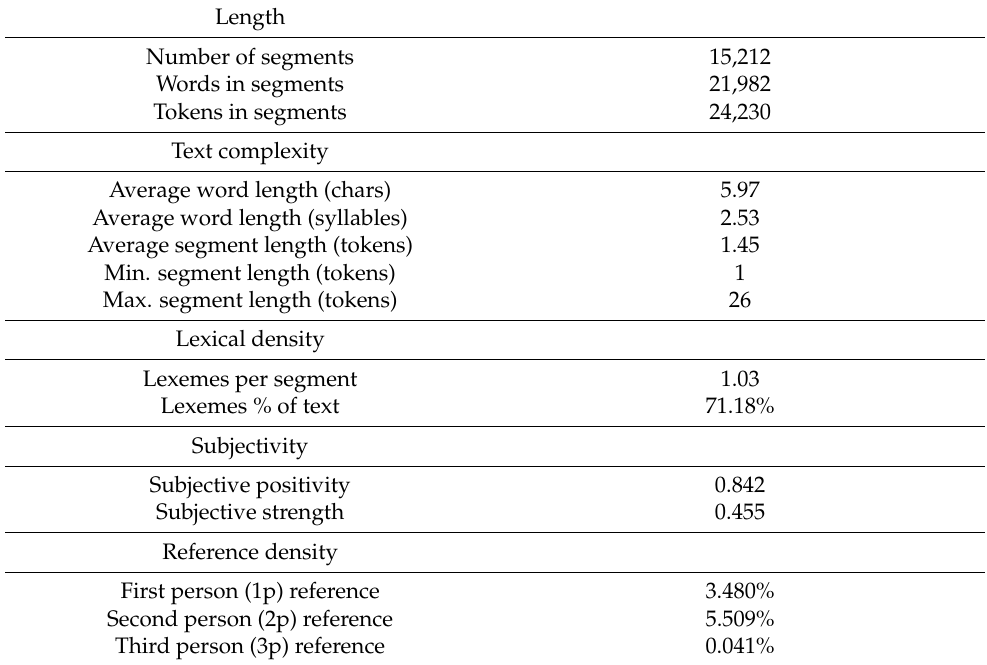
Table 1. General text statistics for the corpus.